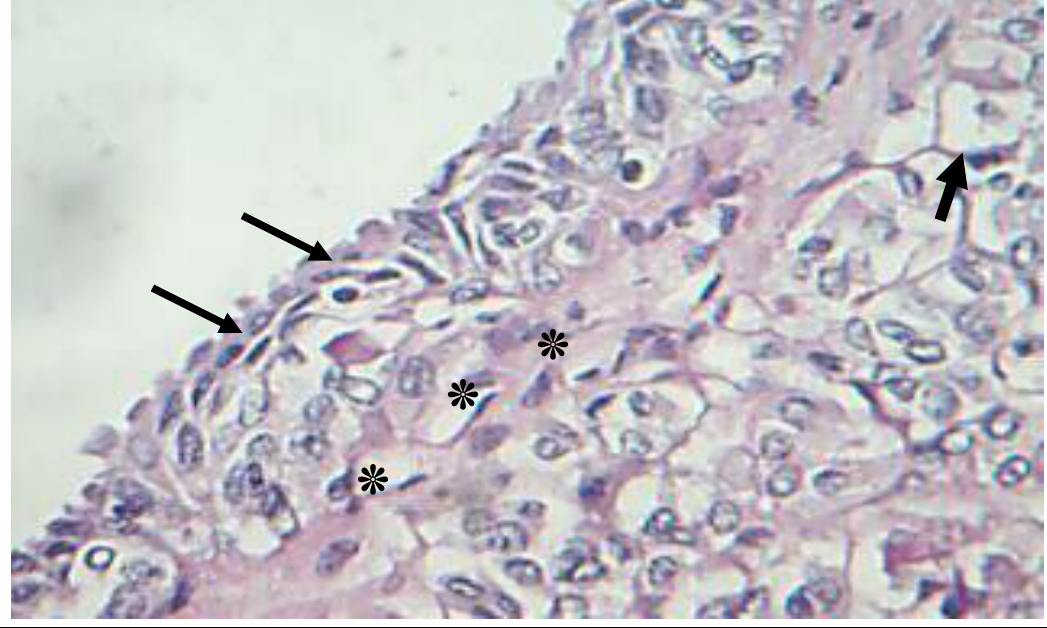
Fig.(1). Pars tuberalis in buffalo showing light cells (small arrow). Double squamous cells (large arrows). Hypophyseal portal system (asterisks). PAS stain. 40 X.